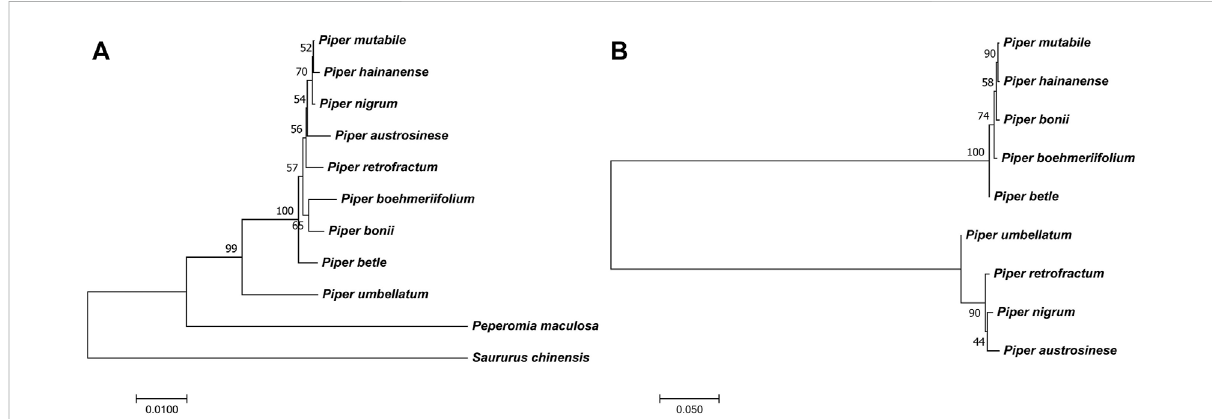
FIGURE 9 The phylogenetic trees. (A) The phylogenetic tree of Piper species [A tree constructed from screened markers. The other trees from the sequence and SNPs of IR and LSC also showed similar results (Supplementary Figure S3)]. (B) The con fl icting phylogenetic relationships that constructed by unsuitable markers from SSC region [The trees from SNPs and sequence of SSC region also showed similar result (Supplementary Figure